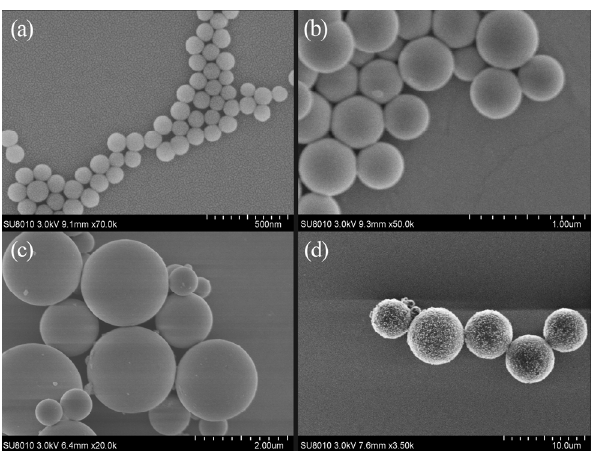
Fig. 2 Scanning electron microscope (SEM) images of the SiO 2 particles used in the polishing experiments with different diameters: (a) 100 nm; (b) 500 nm; (c) 2 µm; and (d) 5